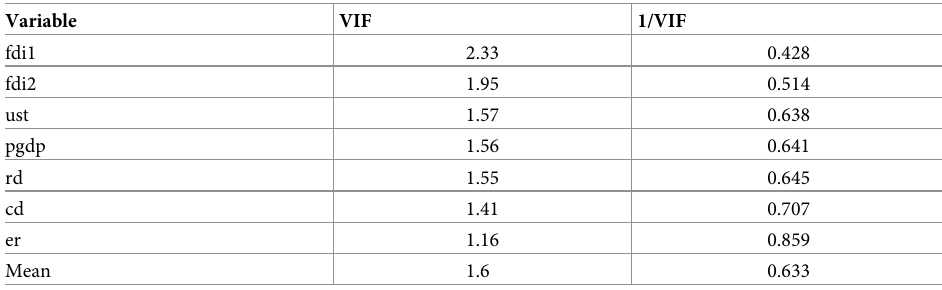
Table 2. VIF multicollinearity test